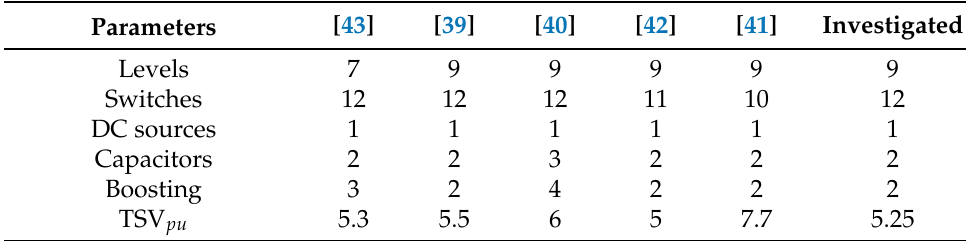
Table 3. Comparison of DB9LI with other